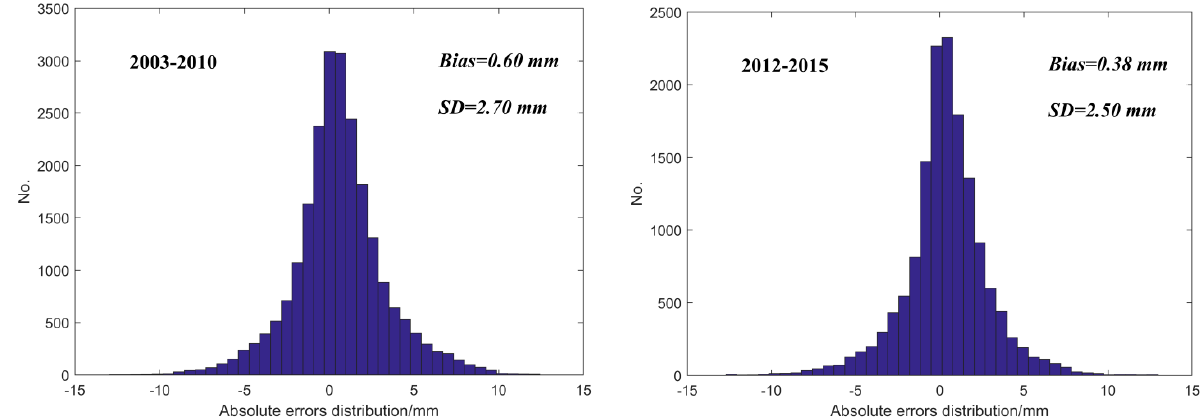
Figure 10. Error comparison of fusion products using different data sources.